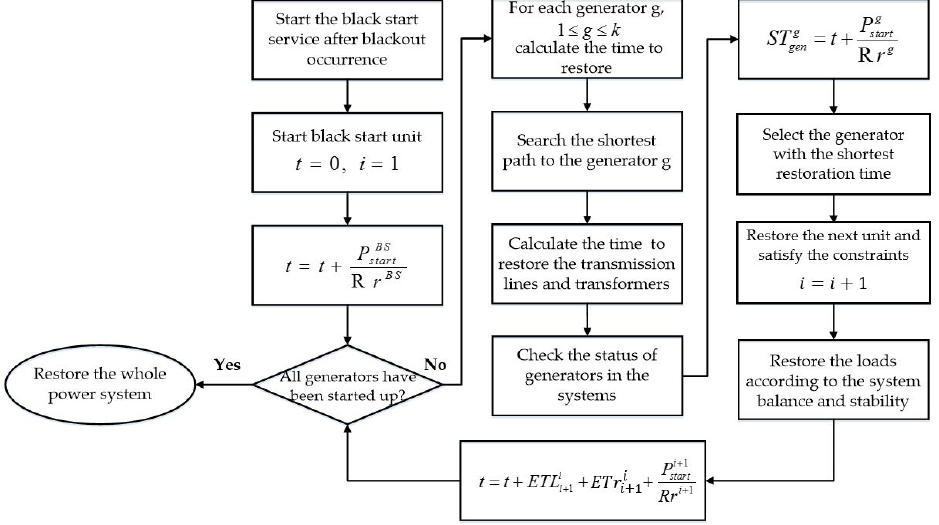
Figure 5. Flow chart of generator start-up sequence.